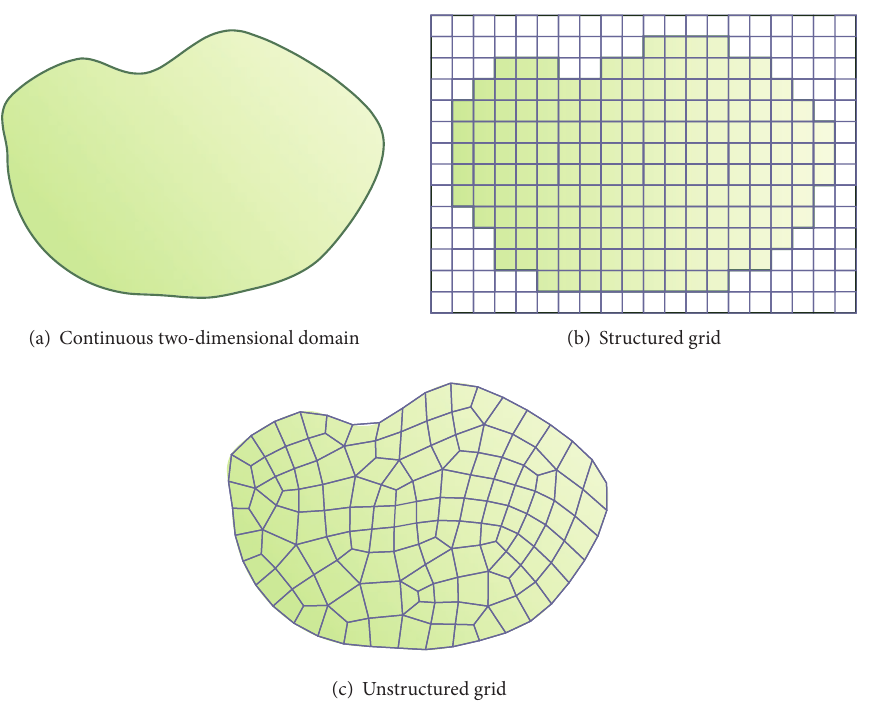
Figure 2: When a continuous domain (a) is meshed with an unstructured grid, there appears a geometric condition known as the staircase effect (b). For the same number of nodes, unstructured grids reproduce the original geometry better (c).